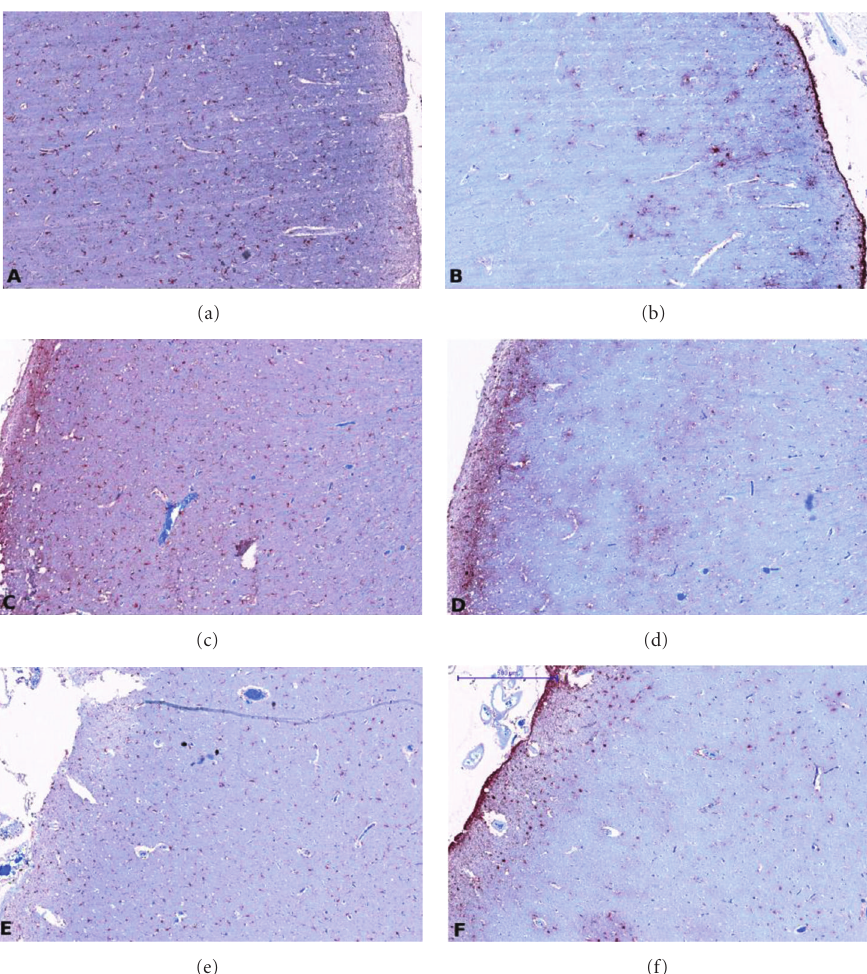
Figure 4: Tissue sections immuno-stained against IBA1 for macrophages and microglia (left column) and against GFAP for astrocytes (right column). ((a)-(b)) represent healthy cortex, ((c)-(d)) NAC, and ((e)-(f)) CL. Tissue sections match the MBP sections presented in Figure 3 ((b), (d), (f)). Bar = 500 μ